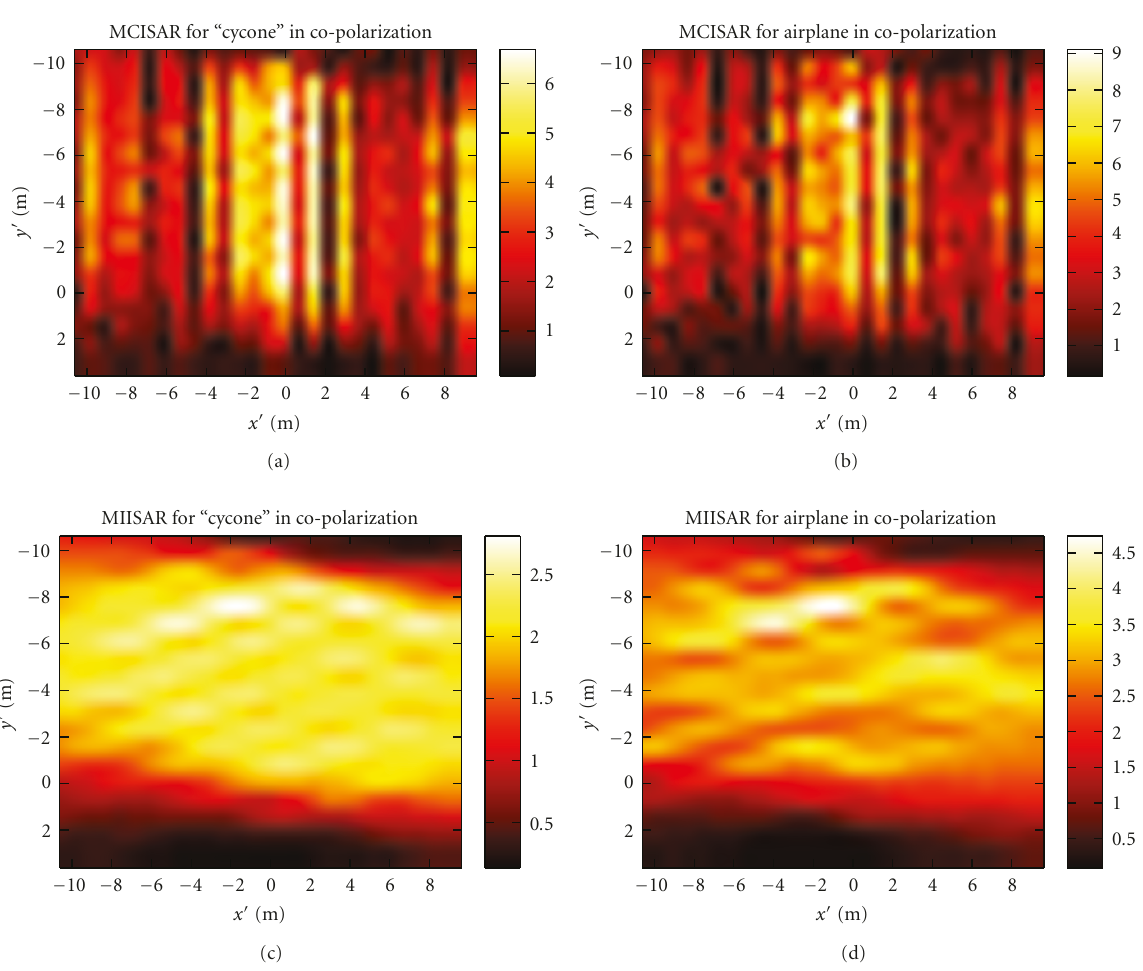
Figure 14: MCISAR results in copolarization of the “cycone” (a) and airplane (b) and MIISAR results in copolarization of the “cycone” (c) and airplane